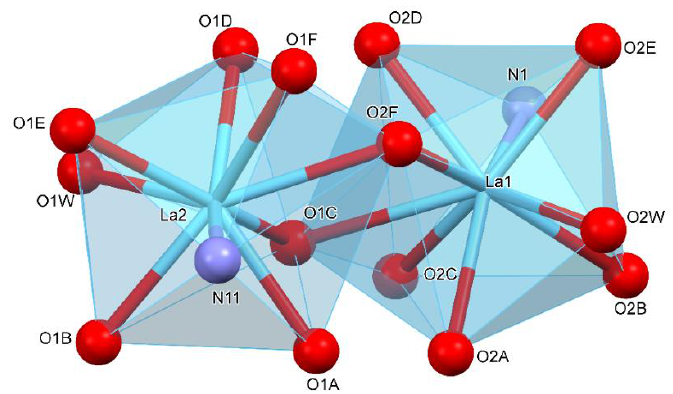
Figure 5. The lanthanum coordinate polyhedron.